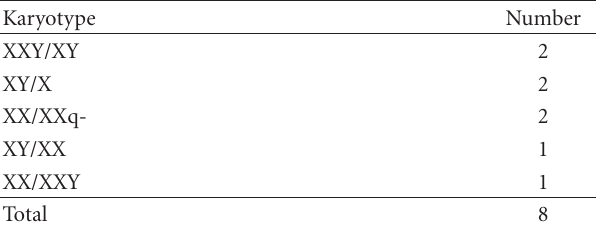
Table 2: Karyotype of patients with chromosomal